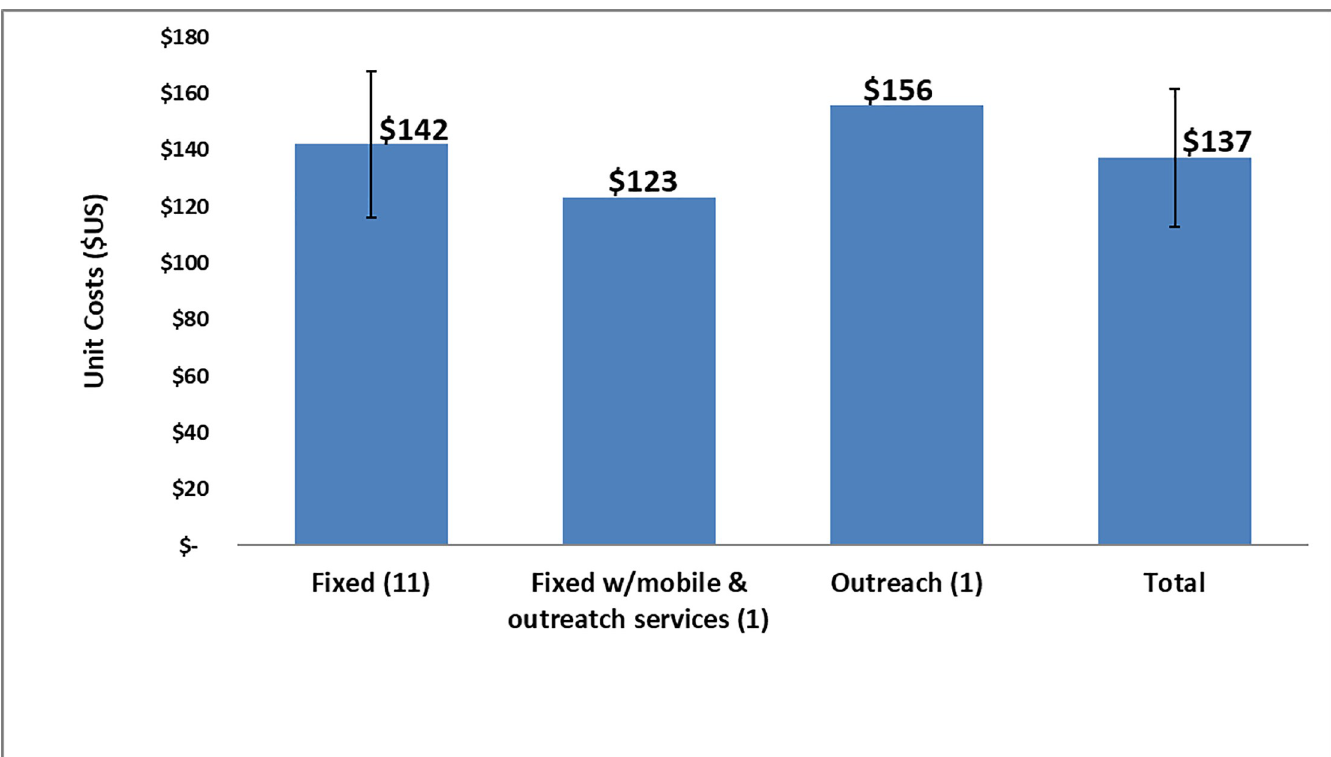
Fig 1. Unit costs by mode of service